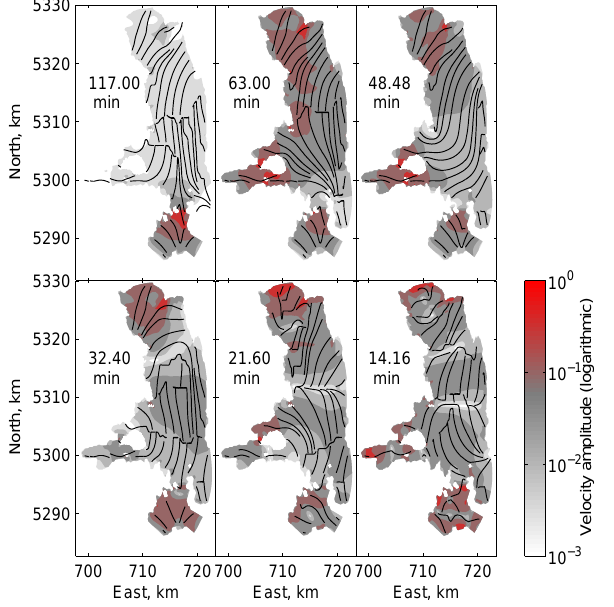
Figure 7. Normalized amplitudes of the velocity oscillations for the six modes with strong intensification of seiche currents in the nearshore areas (red color). Note the logarithmic color scale.